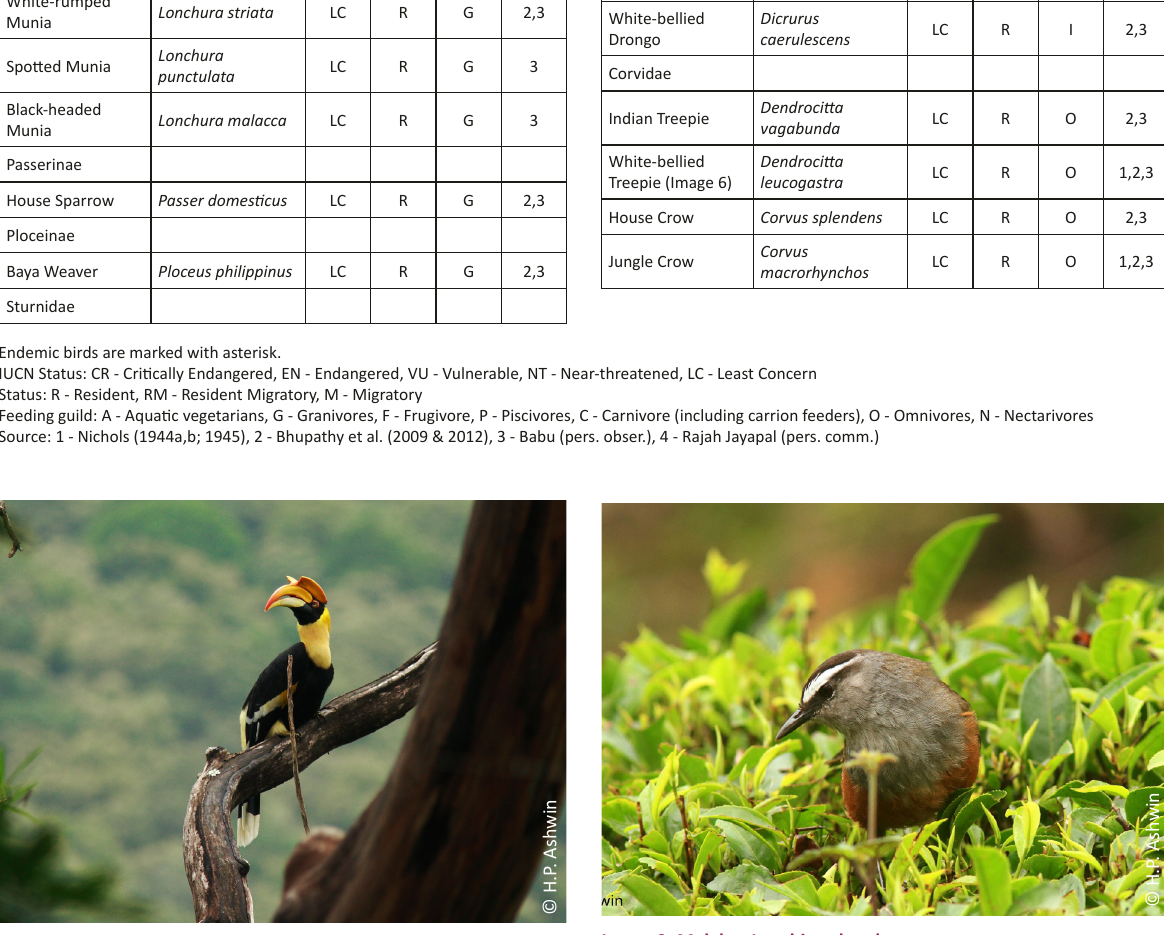
Image 1. Great Pied Hornbill Image 2. Malabar